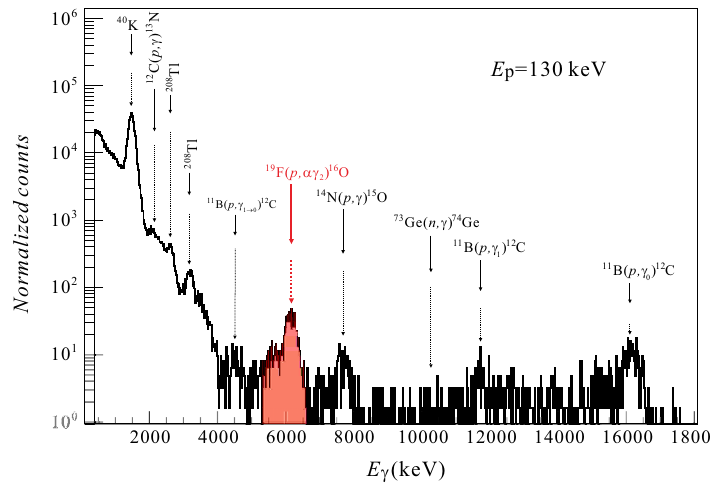
Figure 2. γ -ray spectrum of the 19 F + p experiments measured by a 4 π BGO array at a proton energy of E p = 130 keV